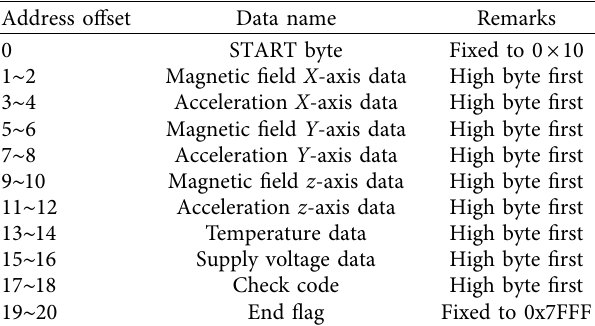
Table 1: Output date format of MODEL544.